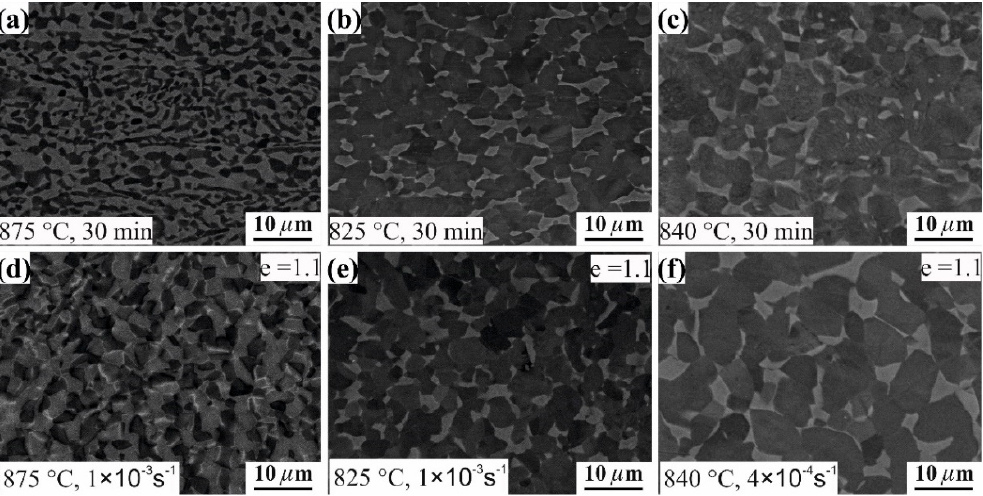
Figure 5. Microstructure of the investigated alloys, after annealing for 30 min ( a – c ) and straining of 1.1 in the testing conditions of maximum elongation to failure ( d – f ) for the tested alloys: Ti-3%Mo-1%V-4%Al alloy ( a , d ); Ti-4%V-6%Al alloy ( b , e ); and Ti-1.8%Mn-2.5%Al alloy ( c , f ).